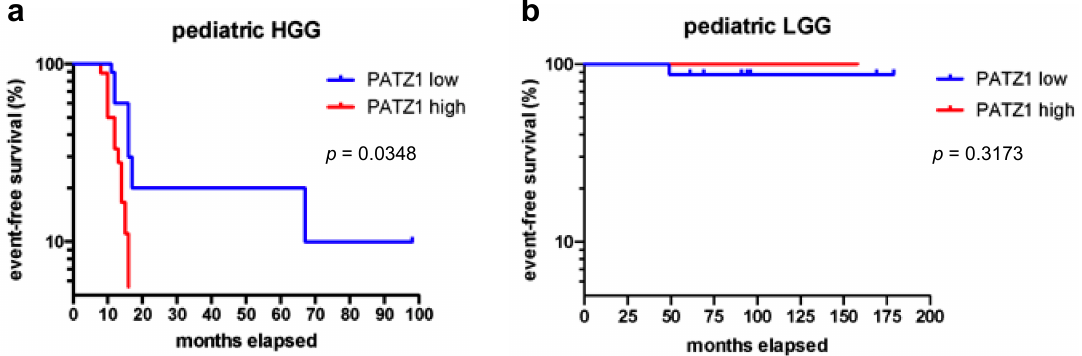
Figure 3. PATZ1 expression found to correlate with worse event-free survival in pHGG. Event-free Kaplan-Meier survival curves of our local cohort of ( a ) 28 pHGG and ( b ) 24 pLGG patients stratified by protein levels of PATZ1, as indicated. pHGG patients with high PATZ1 levels had worse survival rates, as assessed by the log-rank test ( p < 0.05).